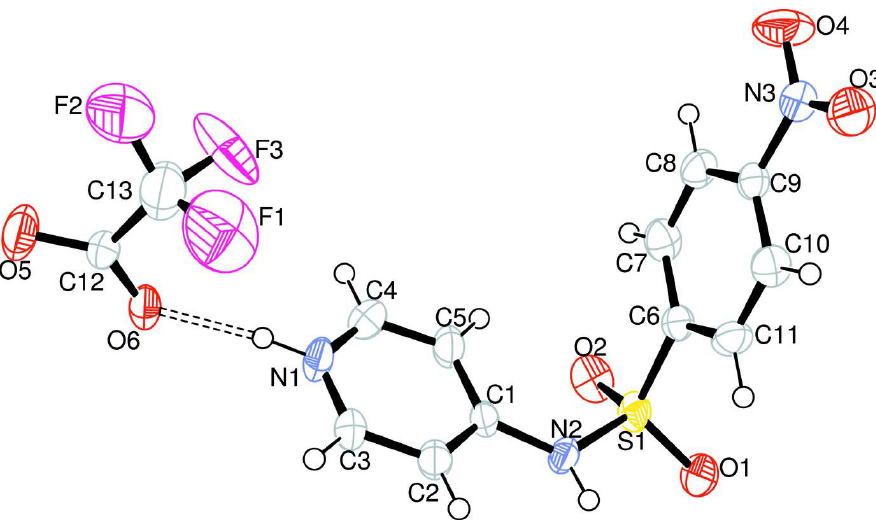
Figure 1 A view of the title compound with displacement ellipsoids drawn at the 50% probability level (arbitrary spheres for the H atoms). The dashed line indicates a hydrogen bond. Only the major component of the disordered CF 4-(4-Nitrobenzenesulfonamido)pyridinium